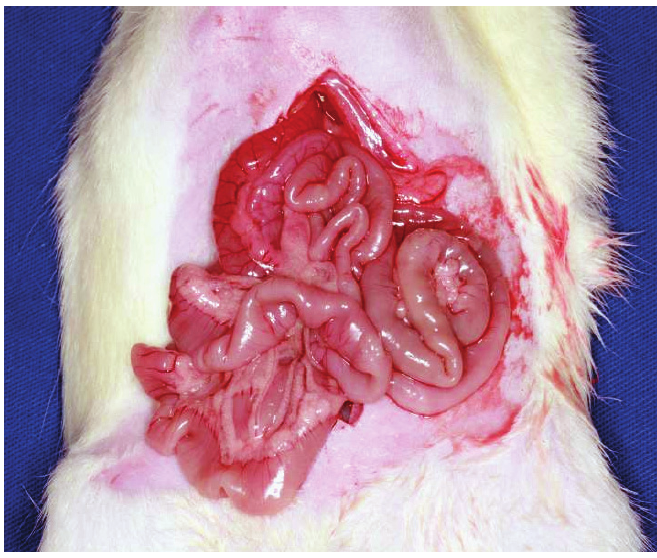
FIGURE 1 - Pale intestinal loops following the placement of the microvascular clamp – Beginning of